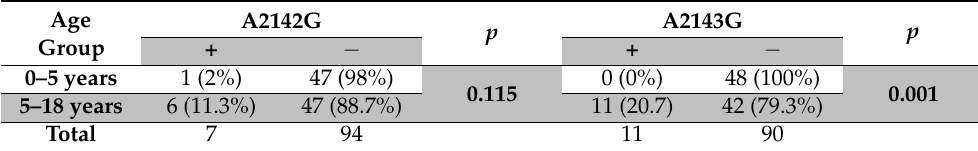
Table 3. The distribution of A2142G and A2143G mutations by age group.